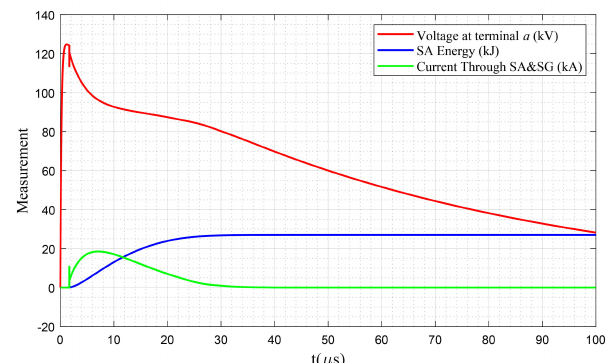
Figure 21. Performance of surge arrester and spark gap connected in series; scenario 3, SA-36a under 125 kV lightning impulse.